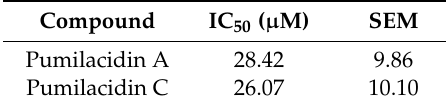
Table 2. The cytotoxic activity of pumilacidins on African green monkey kidney epithelial cells (Vero cells). Data are the means of one experiment run in duplicate.